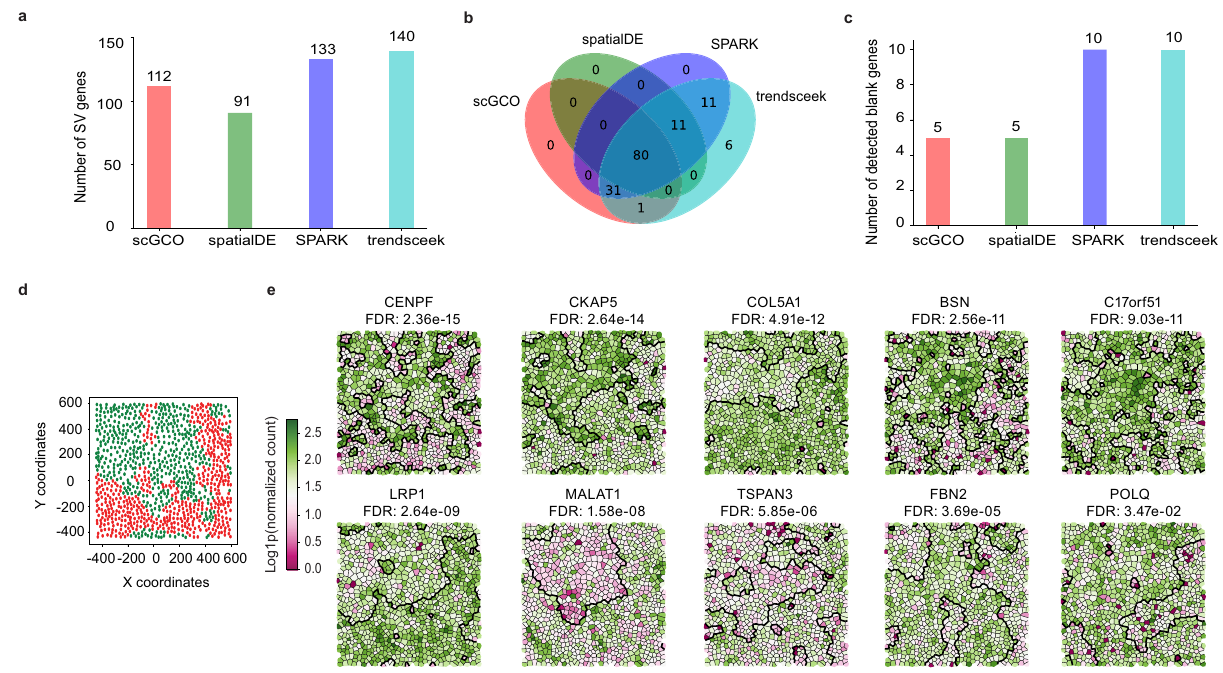
Fig. 5 | Identi fi cation of SV genes in MERFISH data. a Bar charts showing the numberofSVgenesidenti fi edbyscGCO,spatialDE,SPARKandtrendSceek. b Venn diagram showing the overlap of SV genes identi fi ed by different methods. c Bar charts shows the number of blank control genes identi fi ed by scGCO, spatialDE,